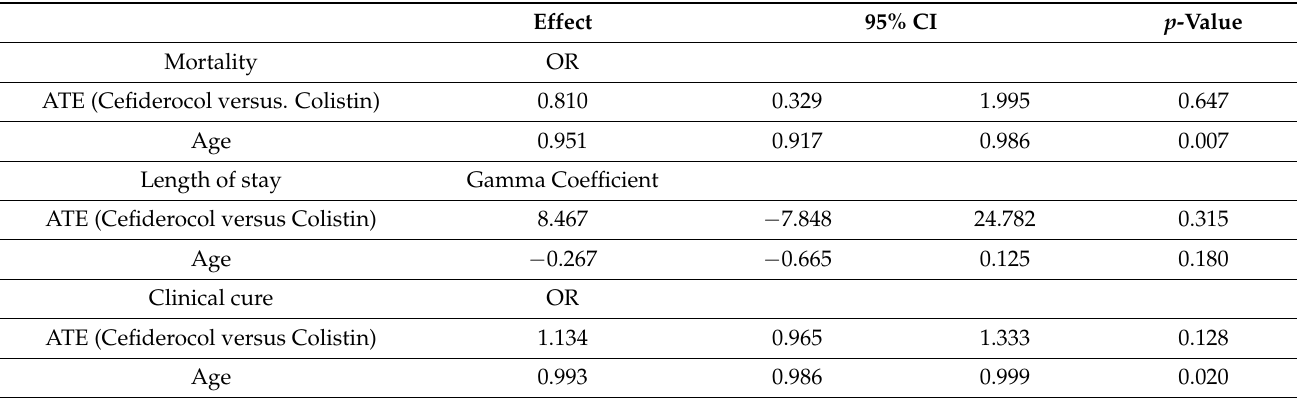
Legend for Table 4: Colistin vs. cefiderocol with regard to mortality, length of stay (LoS), and clinical cure (CC) are further adjusted by age. OR = odds ratio; gamma coefficient is the marginal effect of the gamma-GLM parameter for the LoS (expressed as number of days). ATE effects are adjusted by